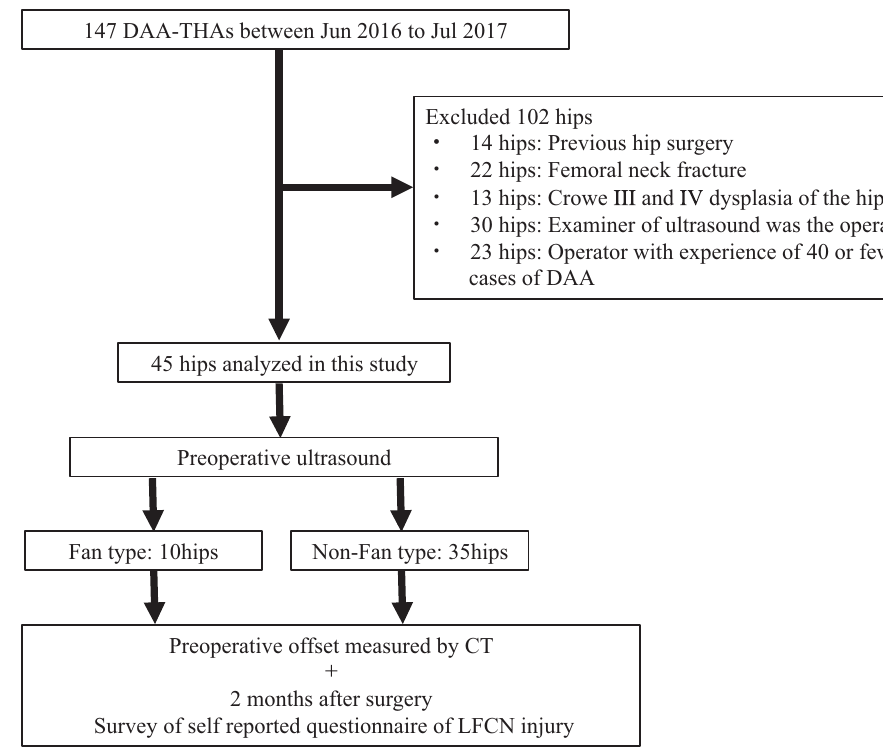
Figure 1. Flow chart of this